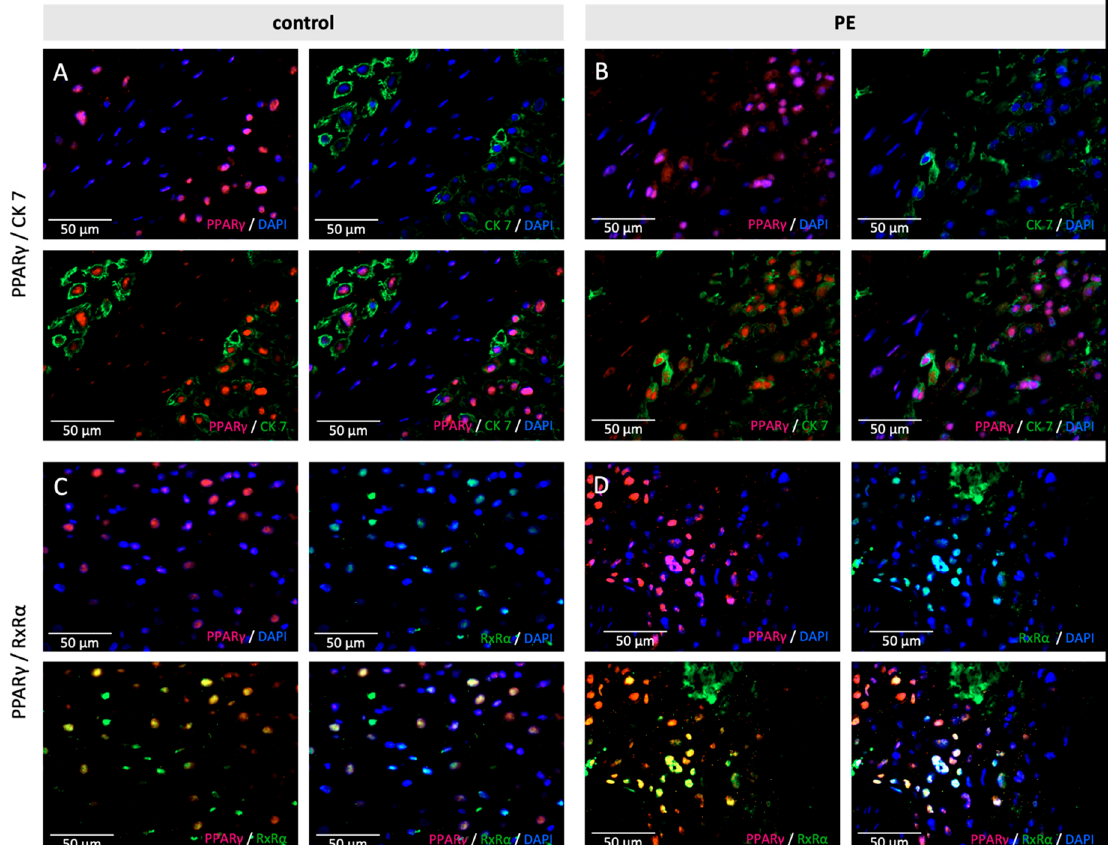
Figure 3. Examples of staining results of the immunofluorescence of PPAR γ with CK7 ( A , B ) and RxR α ( C , D ), in control ( A , C ) and PE ( B , D ) placentas. Single immunofluorescence staining of PPAR γ (pink). Single immunofluorescence staining CK7 or RxR α (green). Double immunofluorescence staining of PPAR γ ( A / B ) and H3K4me3 ( C / D ) (red) and PPAR γ (green). DAPI as nucleus staining (blue). Scale bar 100 µ